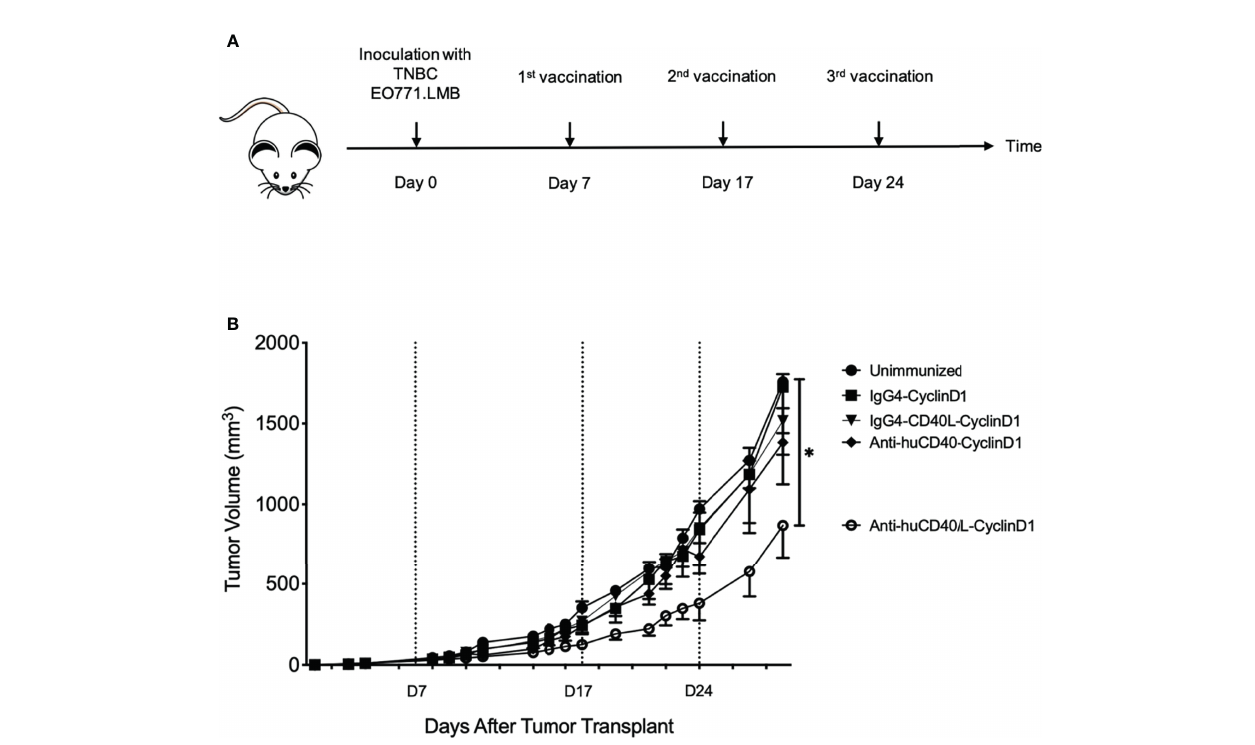
FIGURE 11 | Anti-hCD40-CD40L treatment signi fi cantly reduces tumor burden in a therapeutic setting. Seven days post-inoculation with TNBC EO771.LMB tumor cells, human CD40 transgenic mice were randomized in different groups and vaccinated as indicated in (A) with 20 m g ant-CD40-CD40L vaccine or controls at days 7, 17, and 24. Tumor volumes were recorded by caliper measurements at the indicated time points and presented as mean ± SEM. (B) One representative experiment out of six is shown. Mice where the tumor did not uptake were excluded from the data. Between three and six mice were in each group. Statistics were calculated starting from D14 post tumor injection and statistical signi fi cance was P < 0.05, indicated by